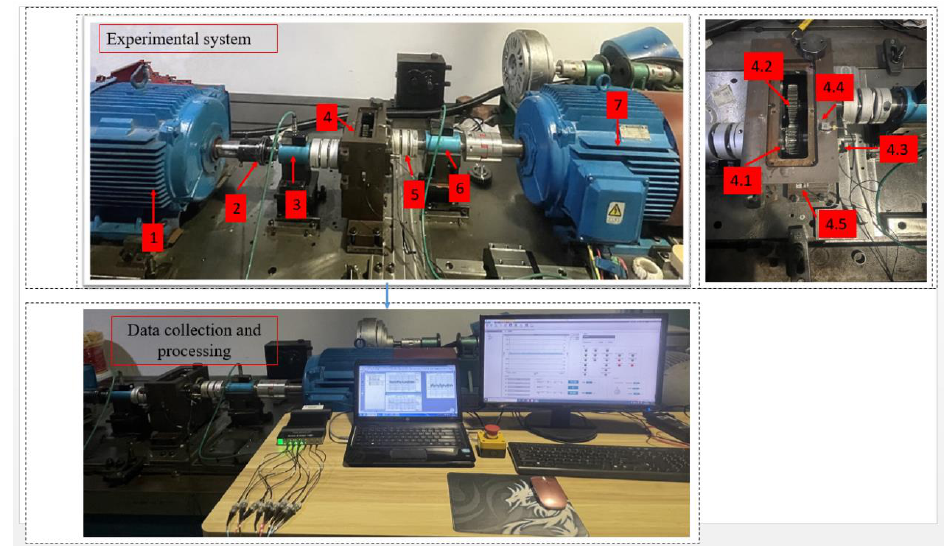
Figure 9. Structural design of the experimental gear.